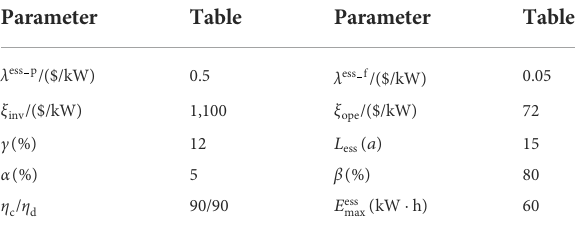
TABLE 2 Parameters of the shared energy storage.